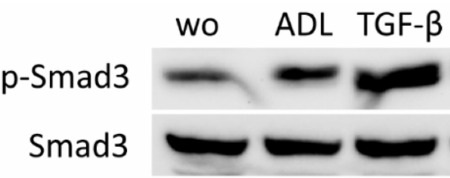
was evaluated by Western blot against p-Smad3. The results showed increased phosphorylation of Smad3 by ADL and TGF- β . Note: “wo” stands for without indicating unstimulated control.